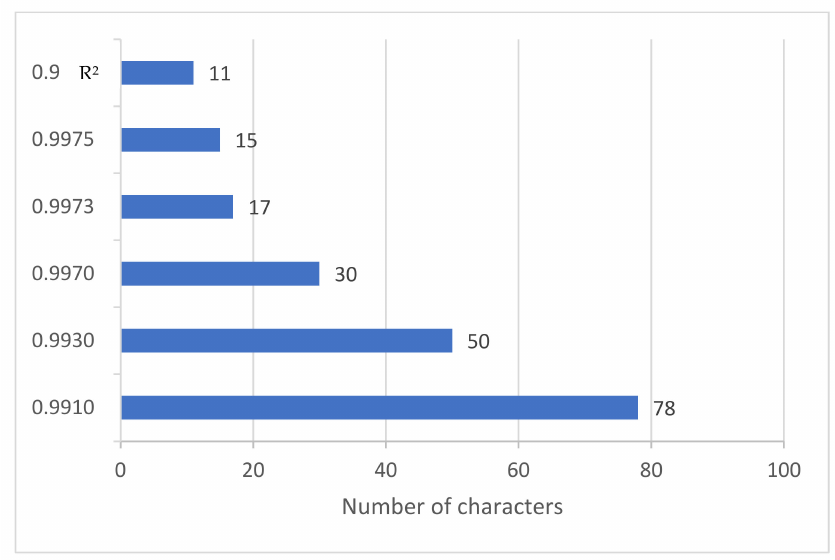
Figure 3. Relationship between the number of features and the correlation coefficient. Among them, the selected feature quantities and the corresponding weights are shown in Table 2 and Figure 4. Table 2. Weight-characteristic quantity